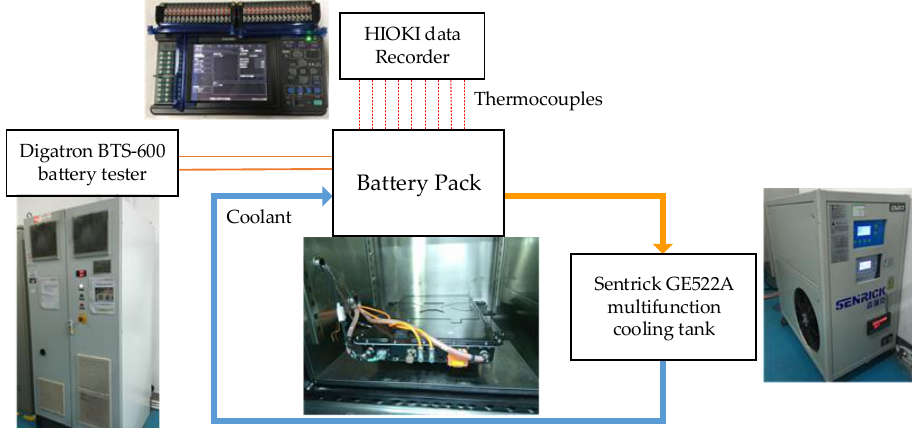
Figure 14. Schematic of the battery pack temperature test platform.